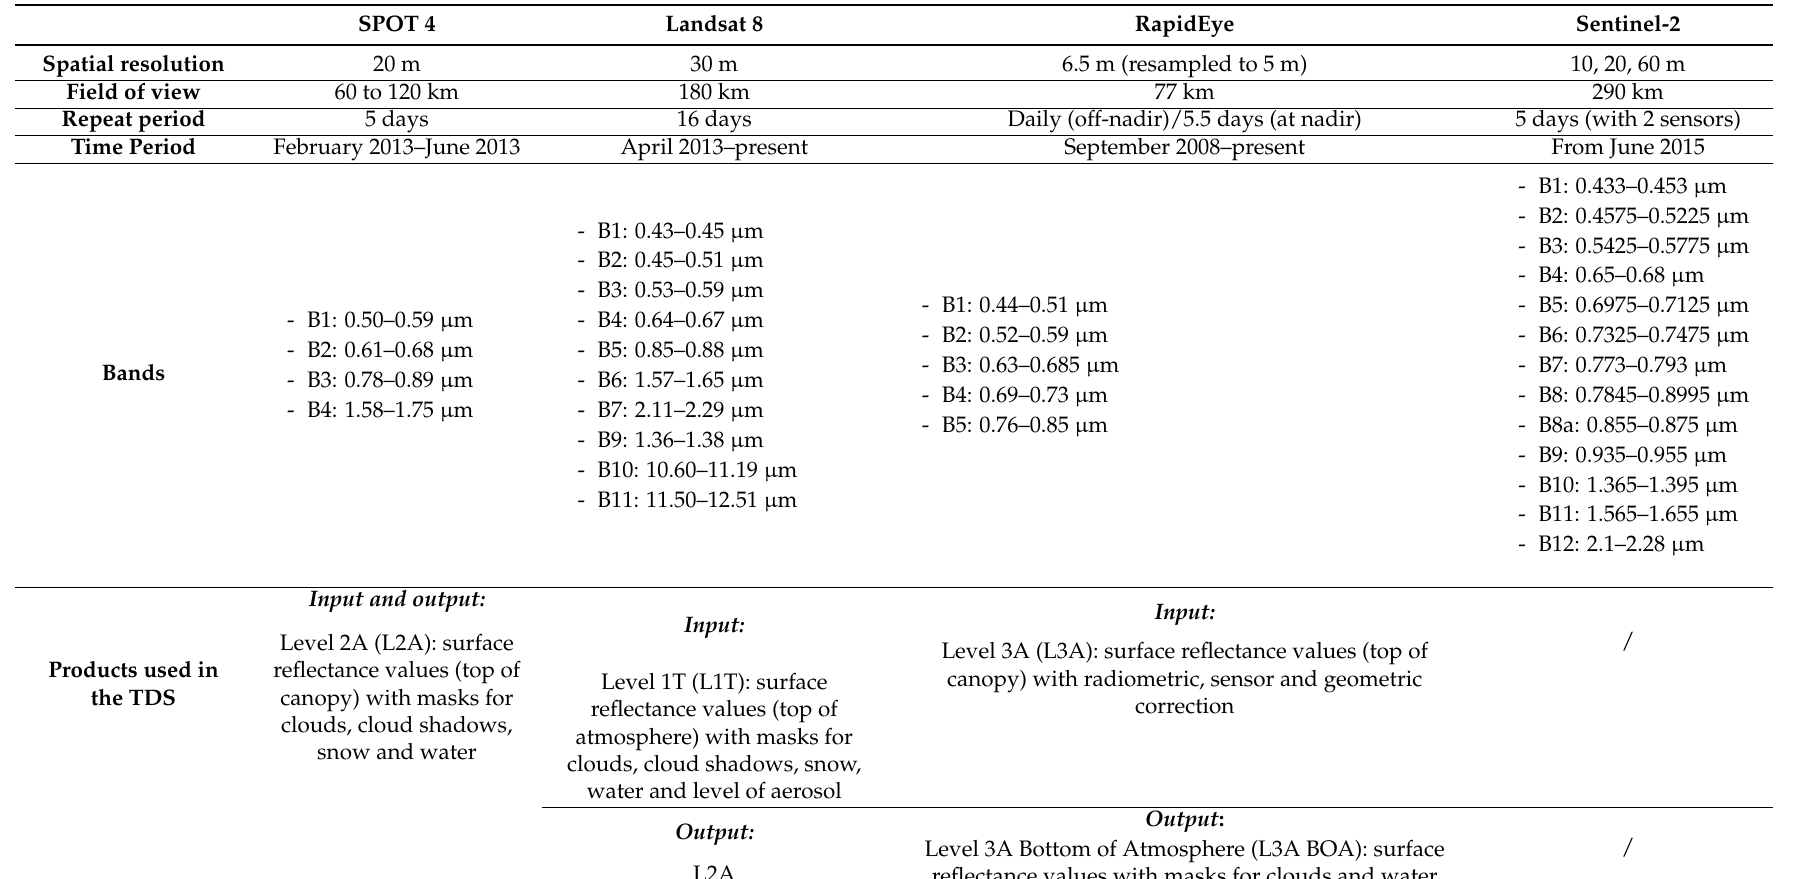
Table 4. Characteristics of the three sensors used to build the EO time series. For the sake of comparison, Sentinel-2 main characteristics are also